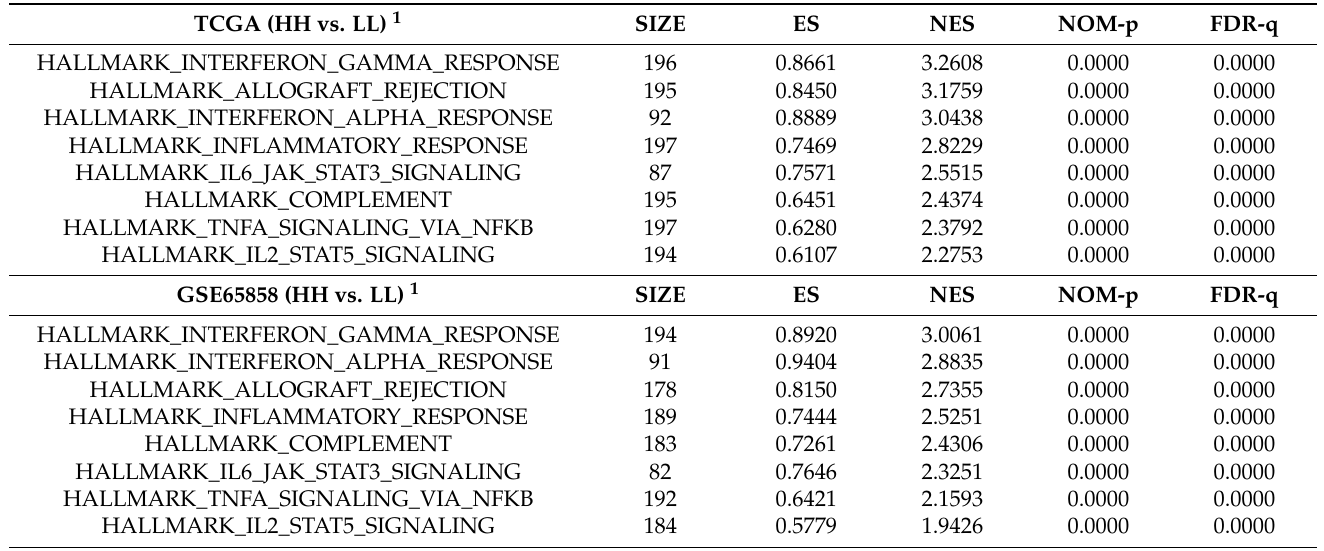
Table 4. Significantly upregulated immune-related Hallmark pathways in HH